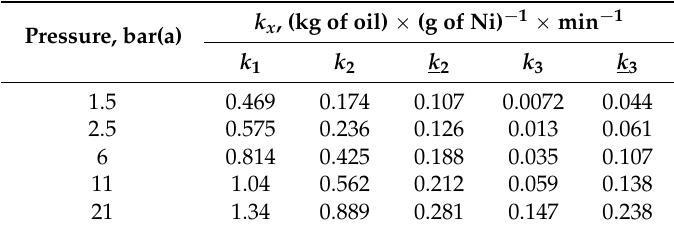
Table 4. Effect of pressure on the apparent reaction rate constants, k x